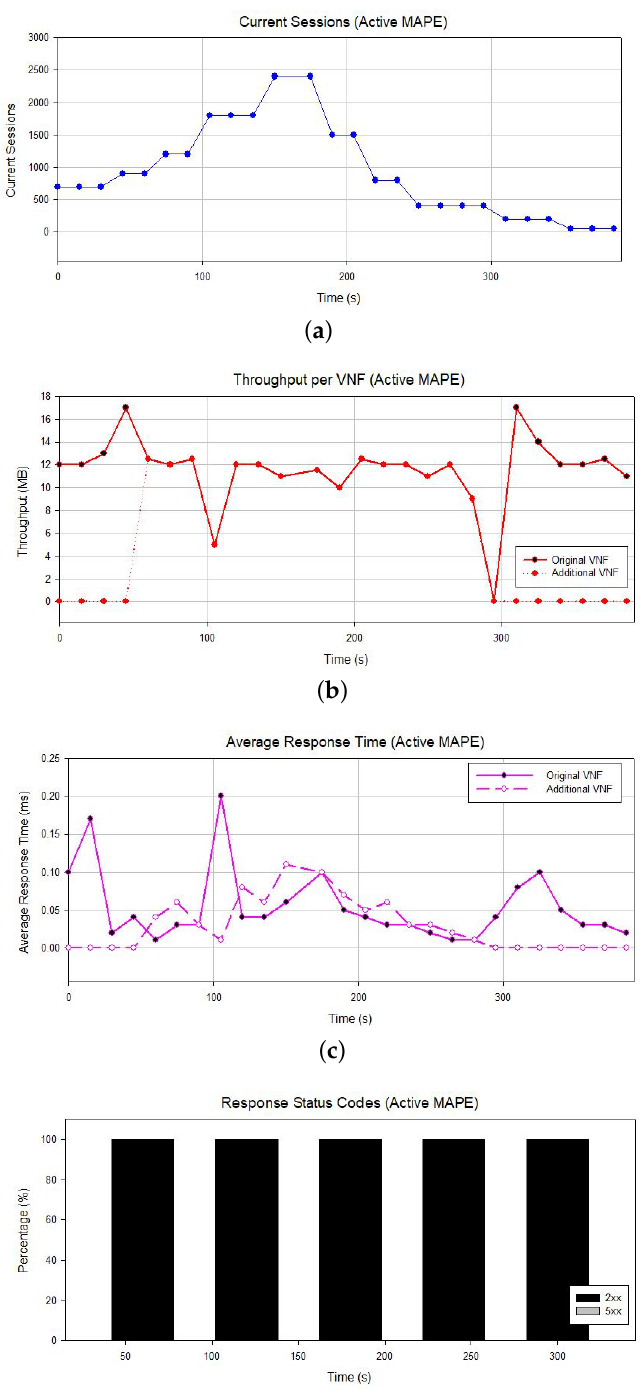
Figure 8. Statistics for active MAPE. ( a ) Active sessions; ( b ) throughput per VNF; ( c ) average response time; ( d ) HTTP response